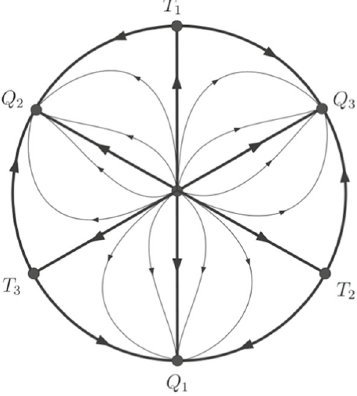
Fig. 6 The phase portrait in the Kasner disc ( (cid:2) ≤ 1) for w = 1. Any solutionbuttheFLRWuniverseatthecenteranisotropizestotheborders of the Kasner disc ( (cid:2) → 1 as a → ∞ ). The saddle-type equilibrium points ( (cid:21) T ’s) have coalesced with the T -Taub points at (cid:2) =